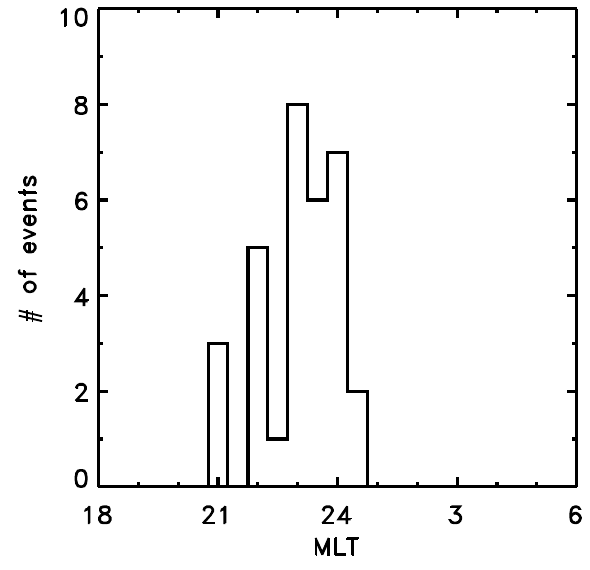
Fig. 2. MLT distribution of substorm onset determined from the global auroral